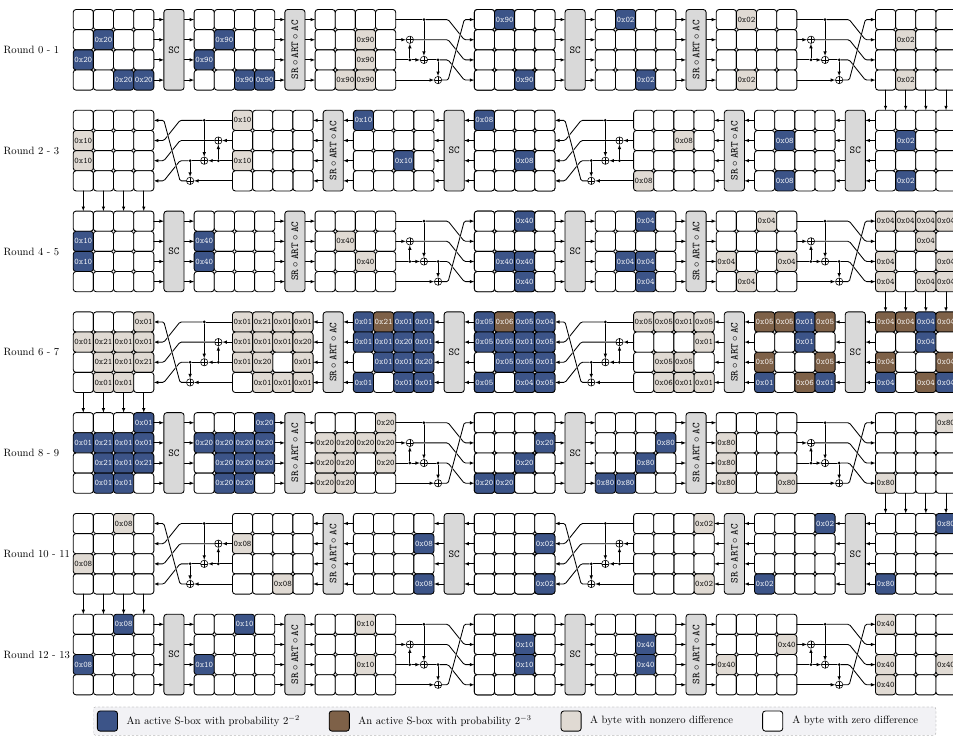
Figure 6: 14-round differential characteristic of SKINNY-128 with probability 2 − 131